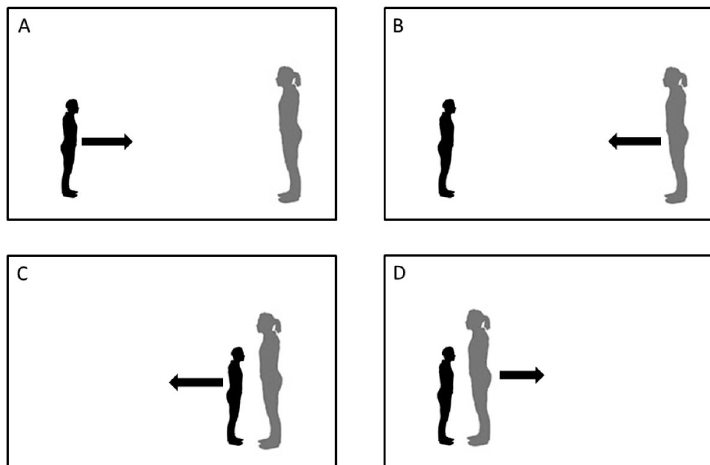
Figure 1. Experimental procedure. In the first condition (A) the participant approached the confederate starting from a far distance (5 m). In the second condition (B) the confederate approached the participant starting from a far distance (5 m). In the third condition (C) the participant moved away from the confederate starting from a close distance (face to face). In the fourth condition (D) the confederate moved away from the participant starting from a close distance (face to face). doi: